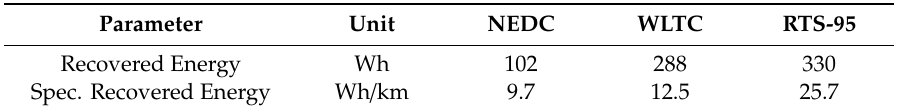
Table 8. Recovered energy on the NEDC, WLTC and RTS-95 for the ST-MHEV and the HE-MHEV powertrain concepts.